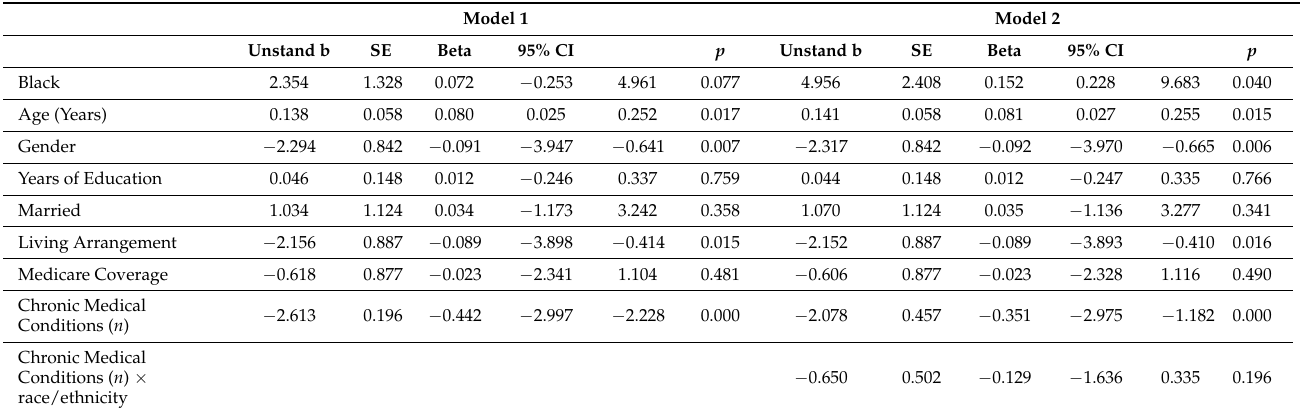
Table 4. Linear regression with physical quality of life as the